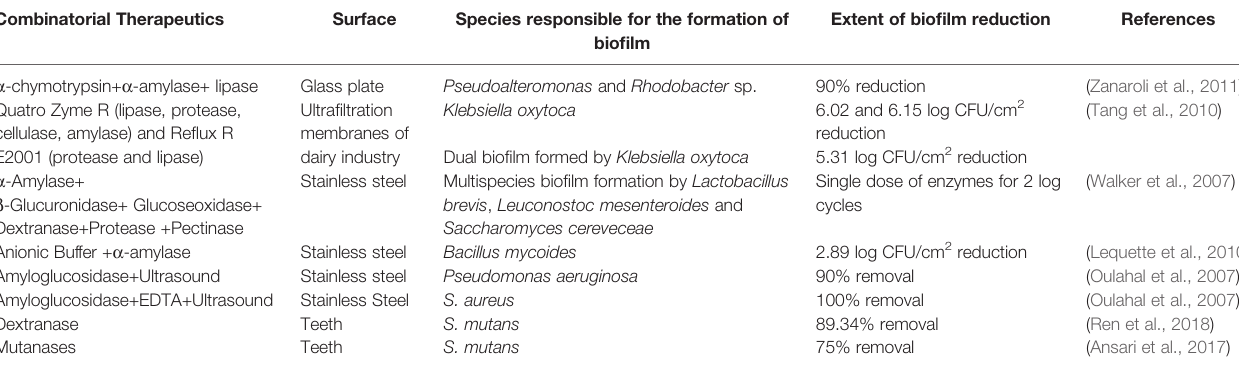
TABLE 2 | Role of enzymes as antibio fi lm agent on abiotic surfaces. Combinatorial